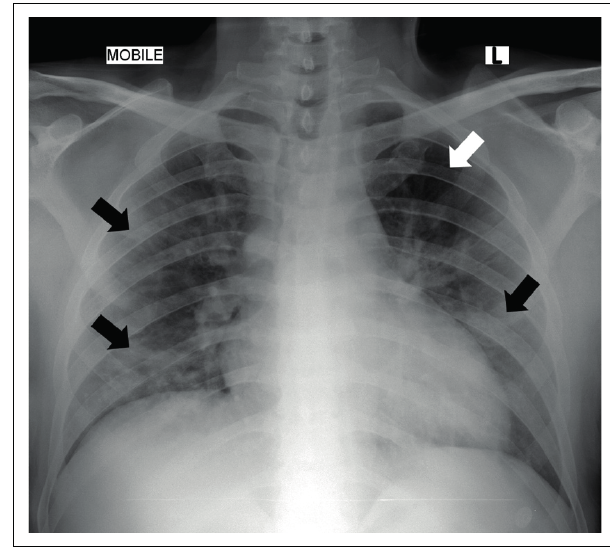
FIGURE 4: Chest radiograph of a 52-year-old man with hypertension, diabetes mellitus and chronic kidney disease who presented with fatigue and malaise. There are patchy, peripheral and central ground glass opacities bilaterally (black arrows), with sparing of the left upper zone (white